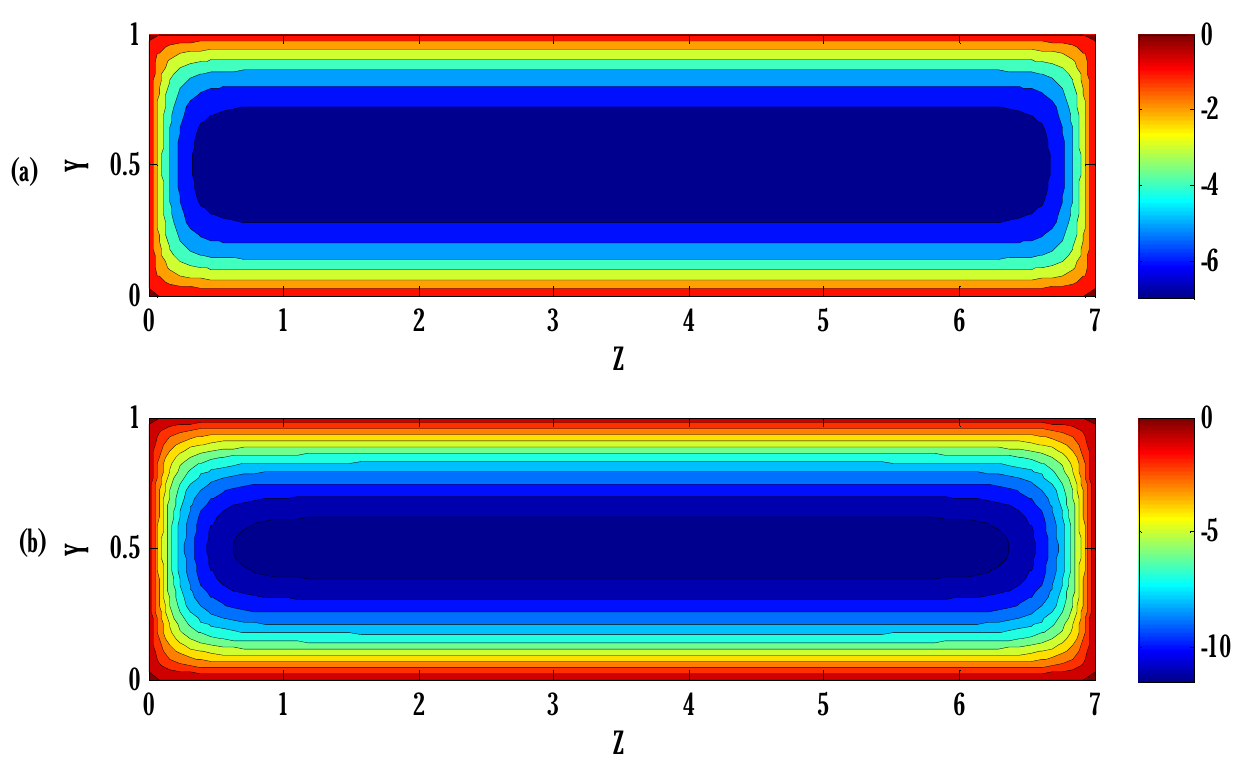
Figure 3. Velocity of the flow at different times ( a ) τ = 0.4998, ( b ) τ = 1 using N τ = 2500, N Y = 40, N Z = 900, ∂ P / ∂ X = −15 .